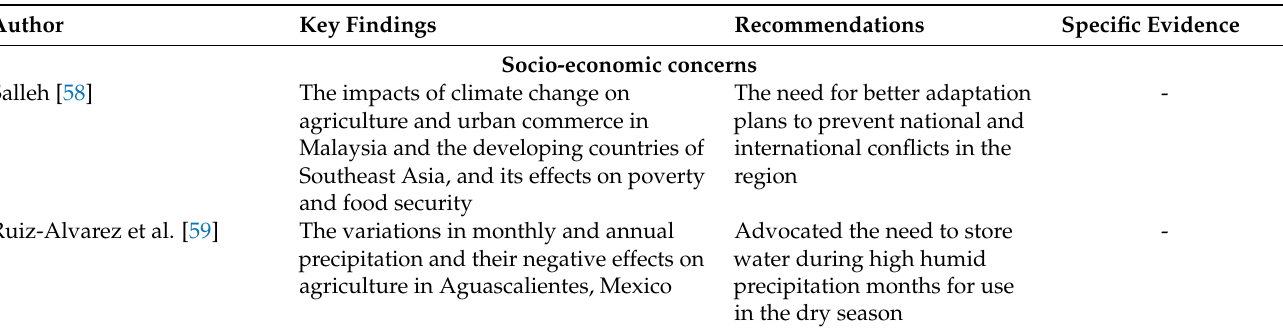
Table 2. Summary of the key findings, recommendation and specific evidence of main concerns. Note: - shows no recommendation or specific